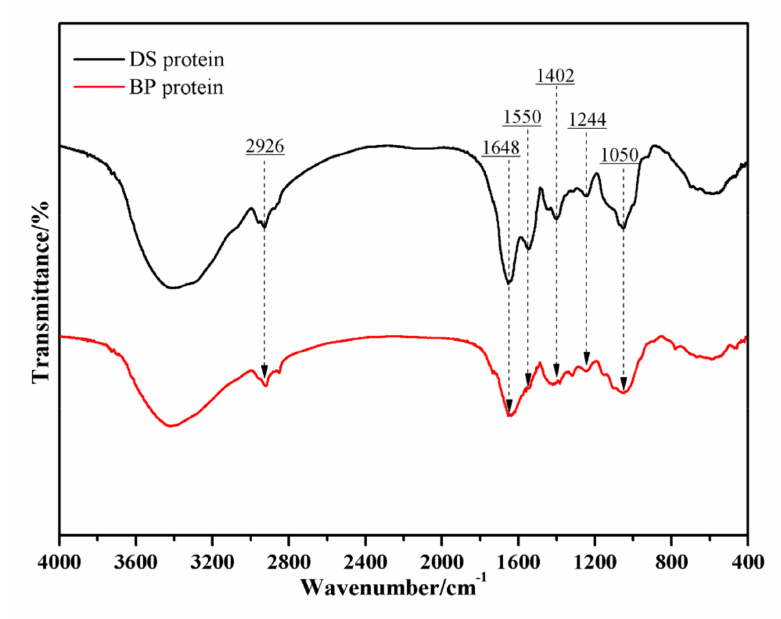
Figure 1. FT − IR spectra of BP protein and DS